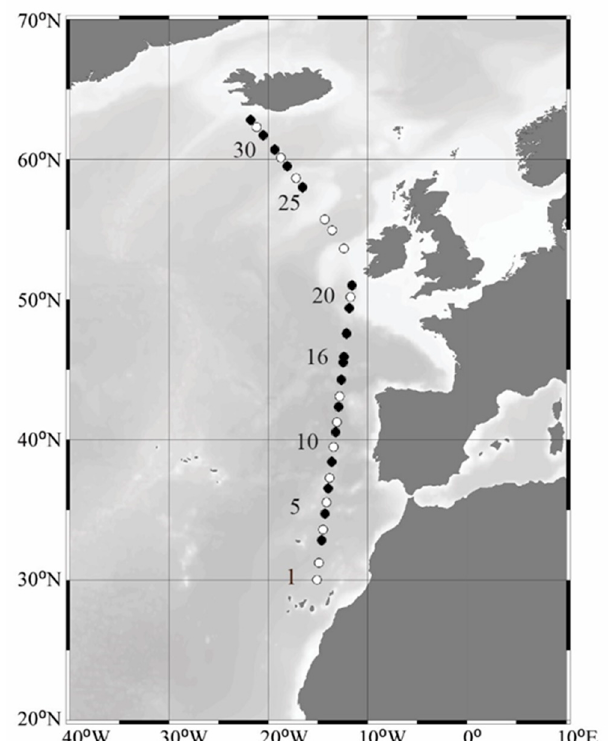
Figure 1. North-south gradient across the Northeast Atlantic Ocean. Bathymetric map depicting stations sampled during the summer STRATIPHYT. Mortality assays to determine viral lysis and microzooplankton grazing rates were performed at stations indicated by black symbols. Figure was prepared using Ocean Data View version 5.2.